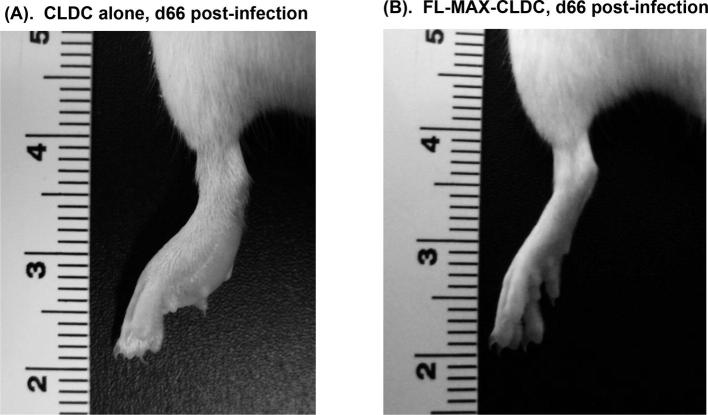
Immunization with FL-MAX-CLDC prevents increase in footpad swelling size following challenge with Lm + MAX. BALB/c mice (n = 5 animals) immunized with either CLDC or FL-MAX-CLDC were challenged subcutaneously in the left hind footpad with 1 x 103Lm metacyclic promastigotes + 10 ng synthetic MAX, and measurements of the effects of immunization on footpad lesion size were determined. Footpad lesion size was determined by measurement of footpad swelling using a digital caliper as described in Materials and Methods. Comparison of representative footpad lesions of mice immunized with (A) CLDC alone vs. mice immunized with (B) the MAX-CLDC reveals significant reductions in cutaneous lesion sizes of MAX-CLDC immunized mice (2 to 3-fold smaller than those of mice receiving CLDC adjuvant only). Images are representative of results obtained from 5 independent experiments. (A): CLDC-immunized BALB/c mouse footpad, day 66 post-challenge. (B): MAX-CLDC-immunized BALB/c mouse footpad, day 66 post-challenge.